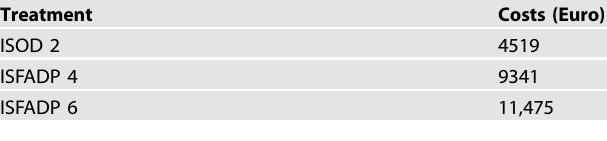
Table 1. Costs of prostheses at delivery (dentist fees and dental technical laboratory costs including costs for implants and implant components).